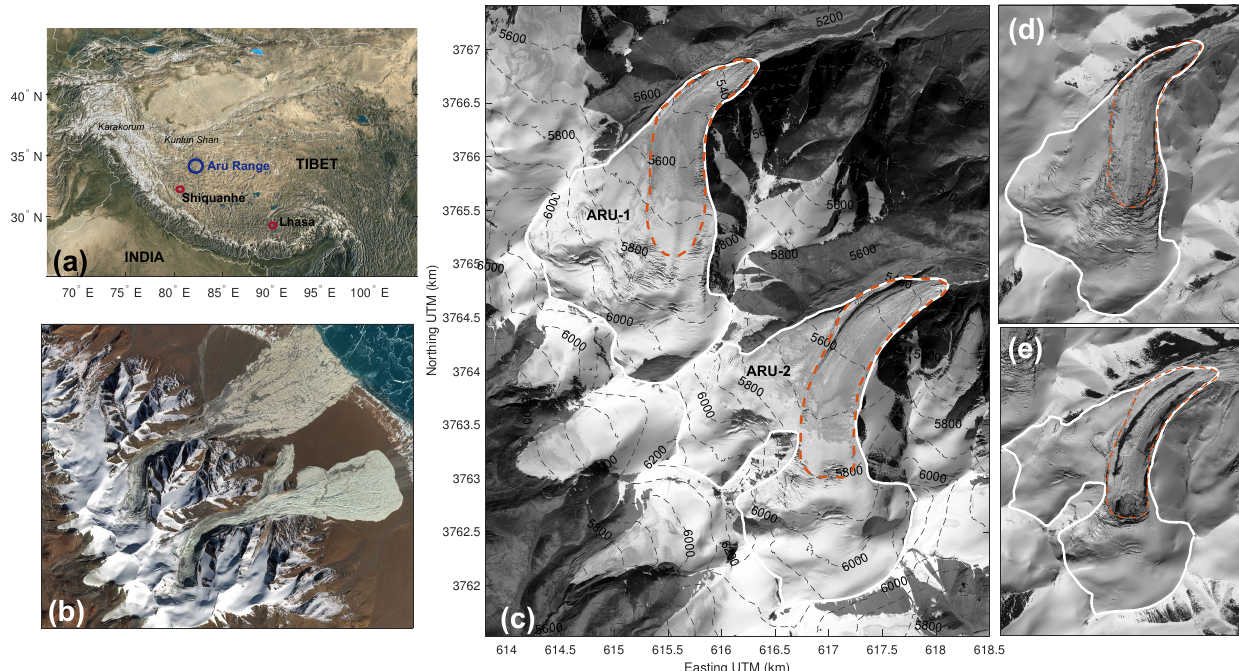
Figure 1. (a) Location of the Aru Range in Tibet and (b) Sentinel-2 image from 8 December 2016 after the collapses (contains modified Copernicus Sentinel data 2016). (c) Elevation contour lines of Aru-1 and Aru-2 glaciers (vertical datum WGS84) overlaid on an orthorectified Spot7 image from 2015 (Copyright Airbus D&S), 21 September as background used also in all other figures unless otherwise stated; orange dashed lines indicate the detachment outline; white lines are the glacier outline as of 2015. (d, e) Pléiades images from 1 October 2016 of the two glaciers Aru-1 (d) and Aru-2 (e) after the collapses (copyright CNES 2016, Distribution Airbus D&S).